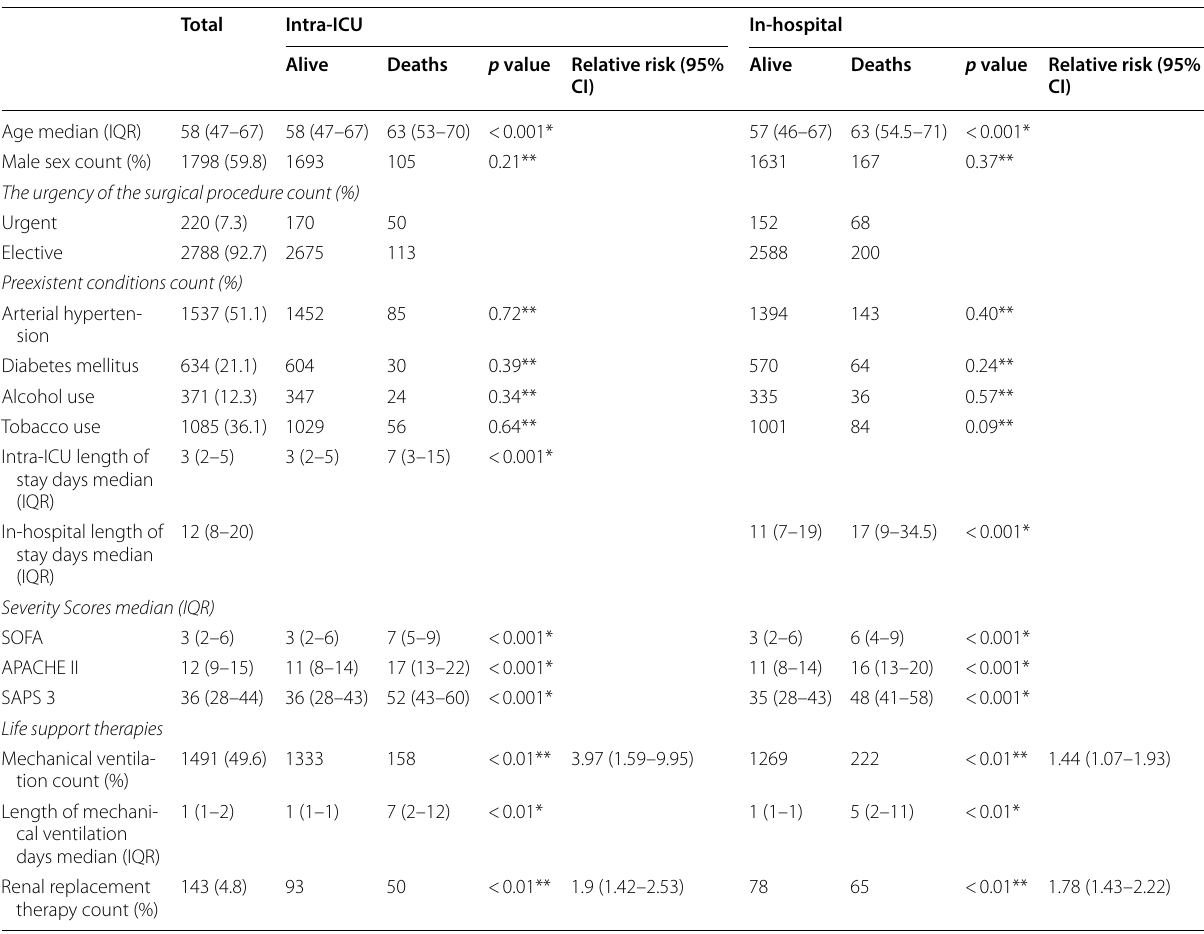
Table 1 Patient’s baseline